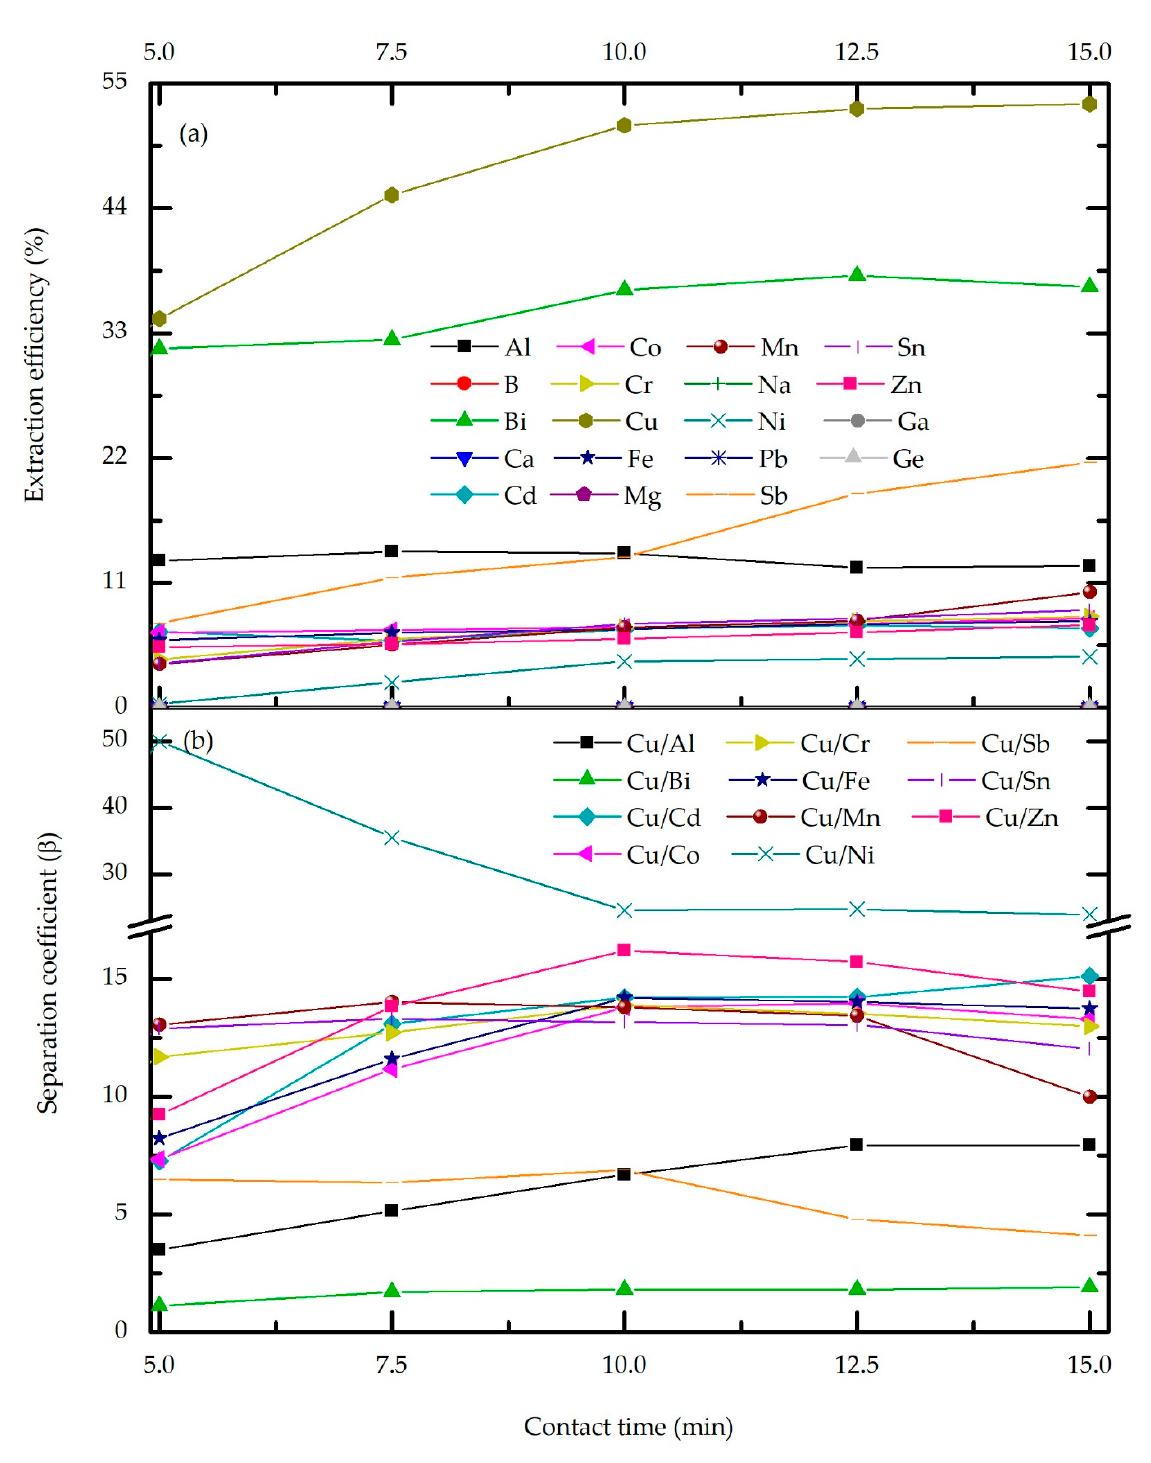
Figure 4. Effect of phase contact time: extraction efficiency ( a ), and separation coefficient ( b ) for the feed pH 0, M5640 20 vol.%, O/A = 3 and temperature 20 °C.